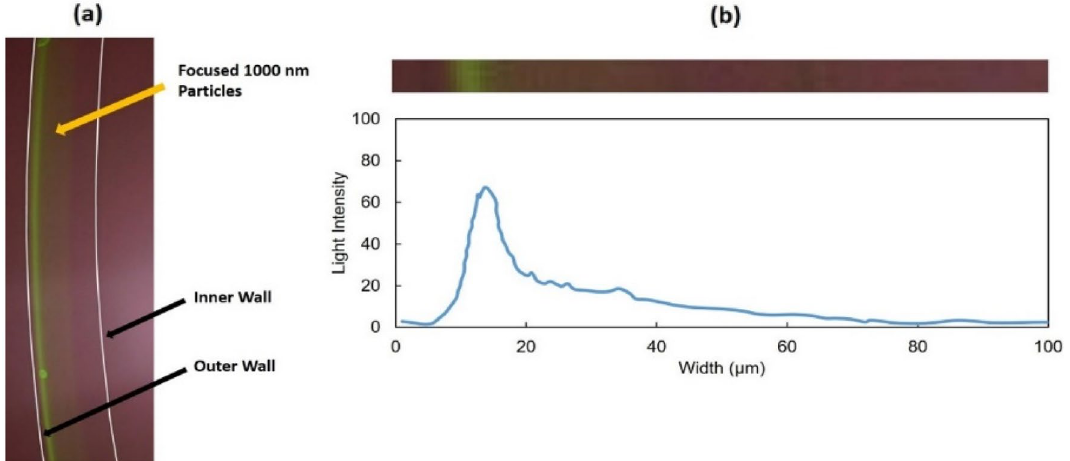
Figure 7. Results of 1000 nm polystyrene particles location imaging test (test B1). (a) Image taken by fluorescent microscope (the walls of the channel are marked by the white lines), (b) the light intensity across the width of the channel based on the image above the